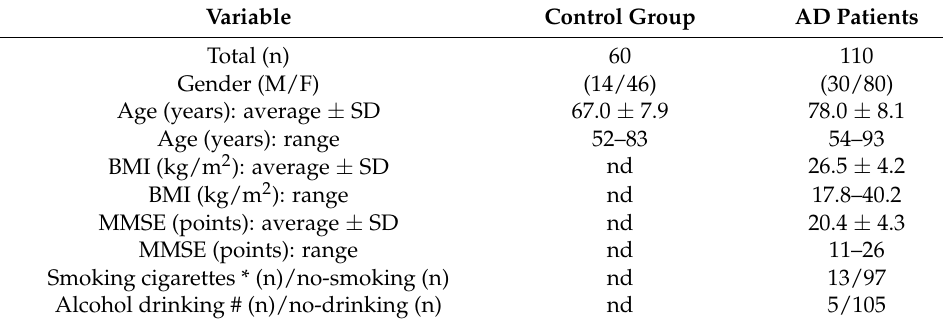
Table 1. Characteristic of the examined groups.